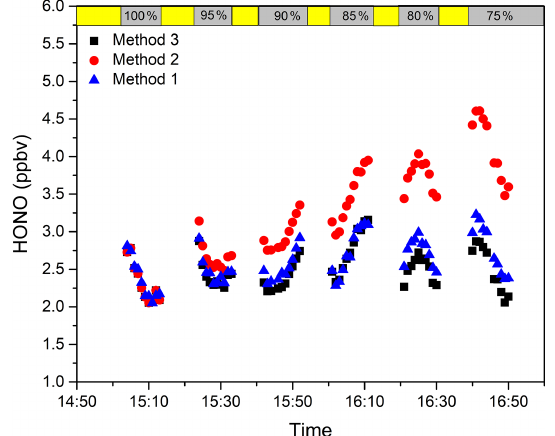
Figure 8. Retrieval results of three methods under different relative light source intensities. The yellow area represents the measuring time of the lamp spectrum, and the grey area represents the atmo- spheric measurement after changing the relative light intensity of the light